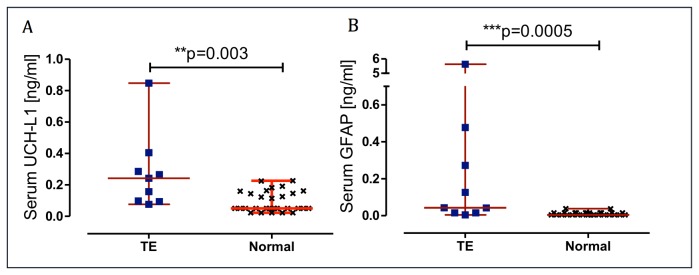
Dot plots demonstrating UCH-L1 and GFAP concentrations.Serum UCH-L1 (A) and GFAP (B) concentrations on admission in TBI patients and in controls. Error bars represent median and range. Significant differences are indicated with ** (P< 0.01) or *** (P <0.001) (Mann–Whitney U-test).